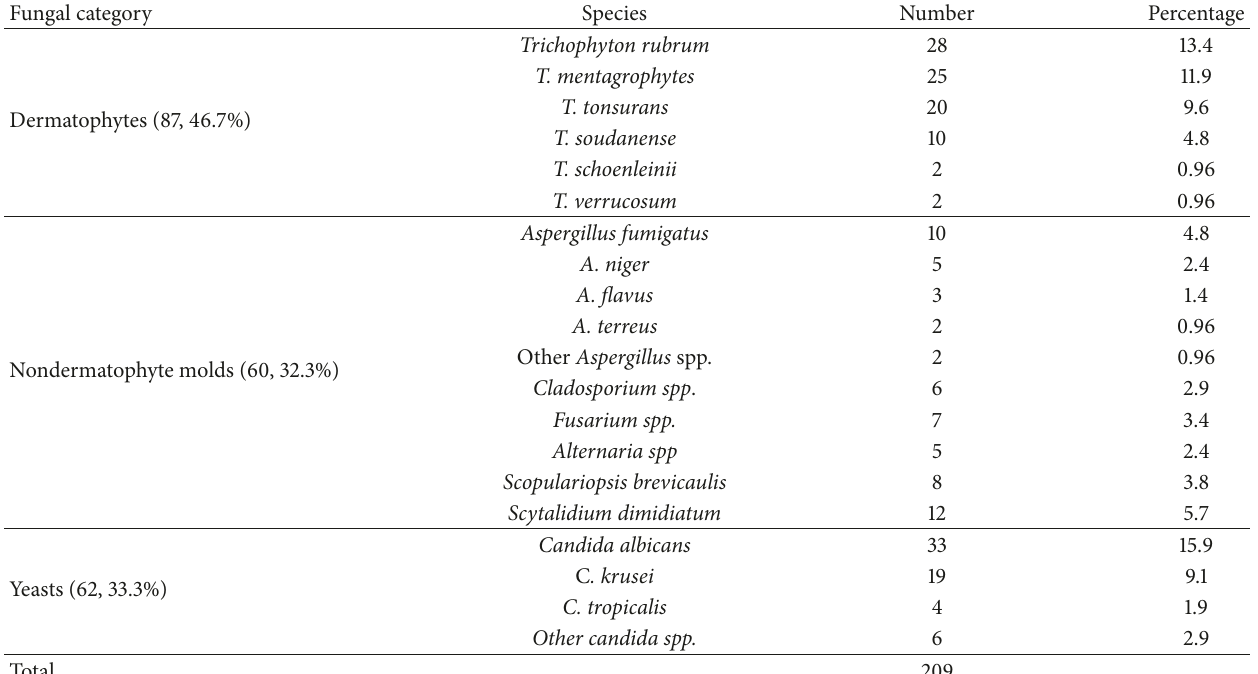
Table 5: Frequency and spectrum of fungal isolates in study subjects